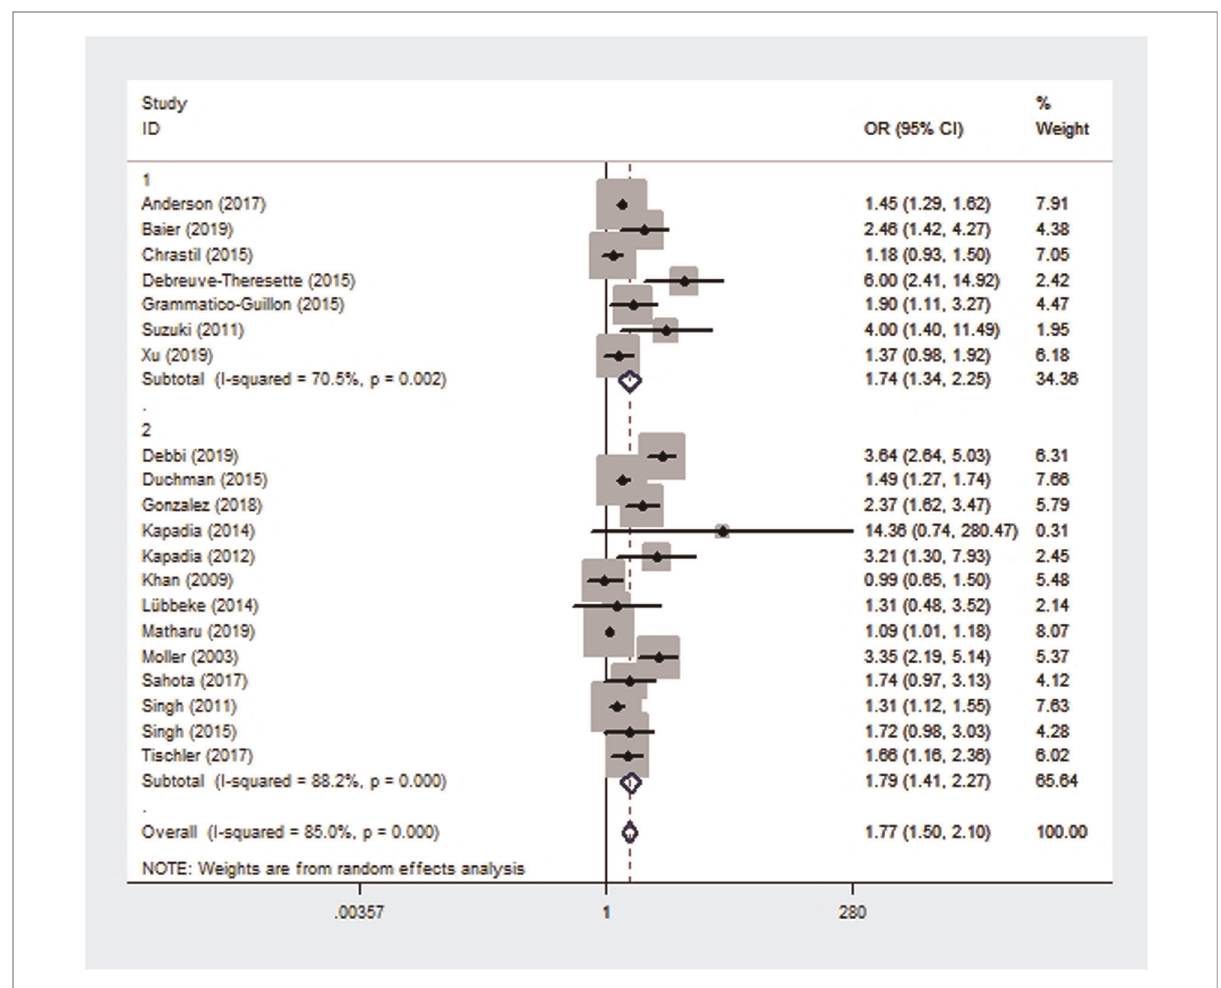
FIGURE 2 Forest plot of subgroup analysis for wound complications based on study type (1: case-control study; 2: cohort